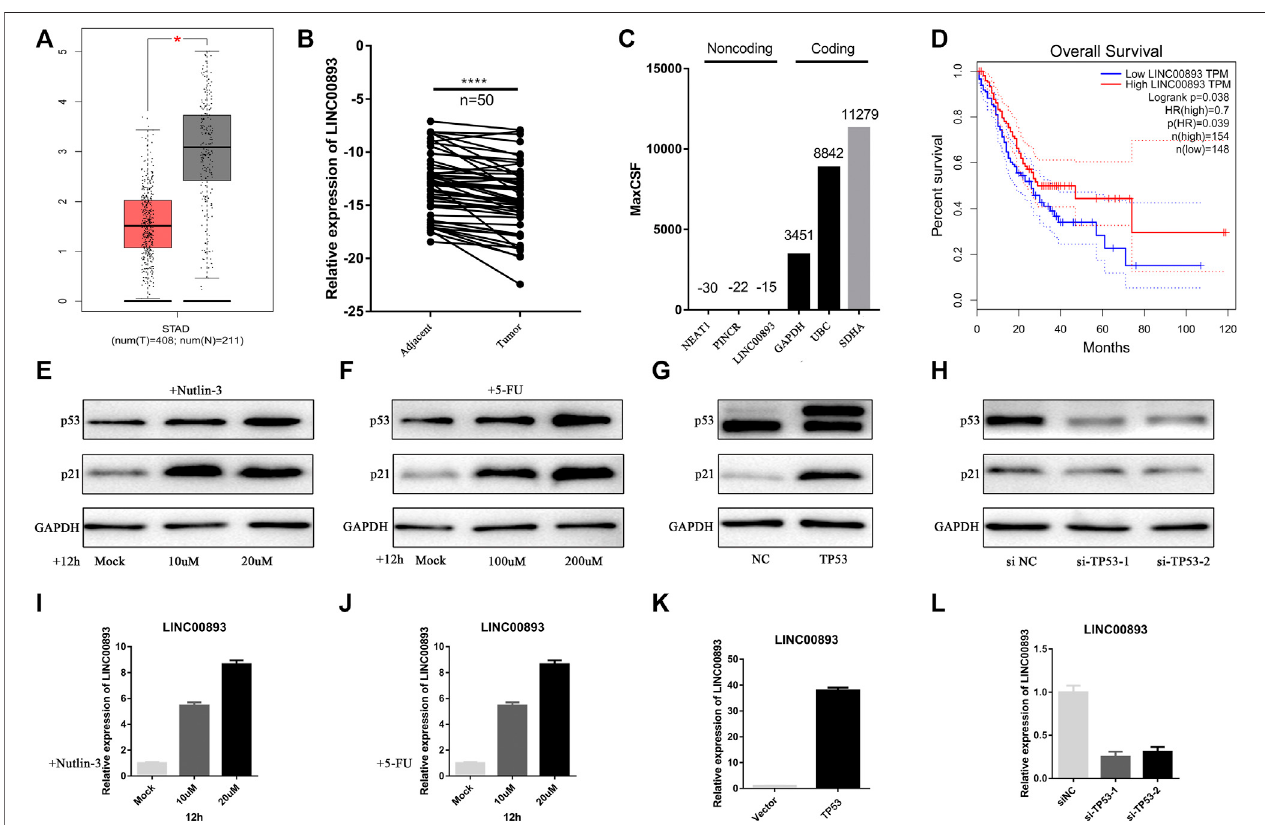
FIGURE 2 | LINC00893 is signi fi cantly low-expressed in gastric cancer and regulated by p53 (A) Analysis of LINC00893 expression in unpaired GC (T (cid:1) 408) and normal tissues (N (cid:1) 211) in the GEPIA ( p < 0.05) (B) Relative LINC00893 expression in 50 paired fresh frozen normal gastric tissues and gastric cancer tissues (C) Maximum CSF scores of LINC00893 as well as other coding and noncoding RNAs determined by analysis with PhyloCSF (D) Kaplan-Meier survival curve indicated the lower expression of LINC00893 associated with poorer survival rates (E,F) p53 and p21 expression in AGS treated with gradient nutlin-3 or 5-FU (G,H) p53 and p21 expression in AGS after transfection of TP53 siRNA or overexpression plasmid (I,J) LINC00893 expression in AGS treated with gradient nutlin-3 or 5-FU (K,L) LINC00893 expression in AGS after transfection of TP53 siRNA or overexpression plasmid. * p < 0.05, **** p < 0.0001, all RT-qPCR results were normalized to GAPDH.